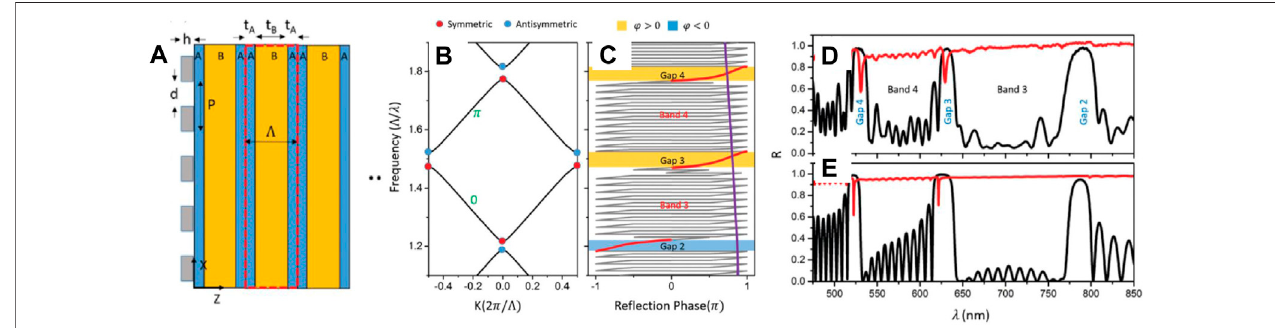
FIGURE 2 | One-dimensional all-dielectric topological PhCs [65]. (A) Schematic structure of the silver fi lms/PhC systems. (B, C) Inner connection between Zak phase and the sign of re fl ection phase, where (B) gives the photonic band structure with Zak phase and (C) displays the re fl ection phases of the 1D PhCs. (D) Experimental and (E) numerical re fl ection spectra of the PhC (black line) and the silver fi lm/PhC (red line). Reproduced permission with Ref.